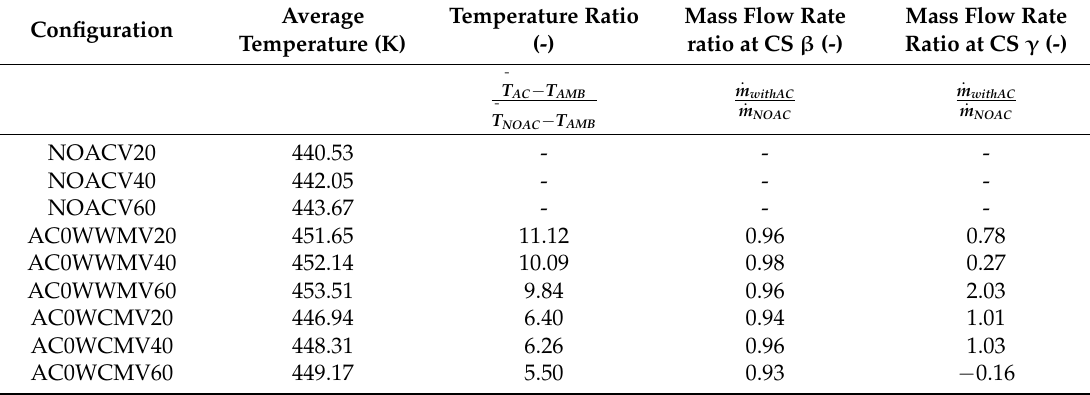
Figure 19 . Adiabatic wall effectiveness coefficient distribution for the reference configuration without air curtains and the best configuration with warm air curtains, at 60 m/min fabric speed. Table 8. Comparison of temperature fields and mass flow rates.